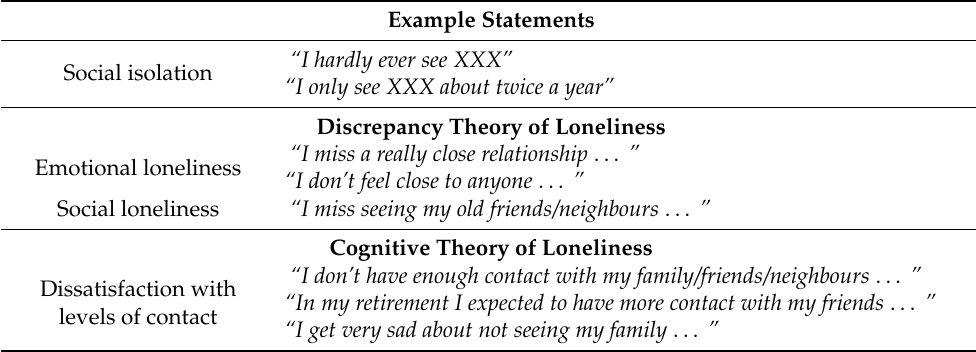
Table 1. Example interview statements for classifying social isolation and loneliness.